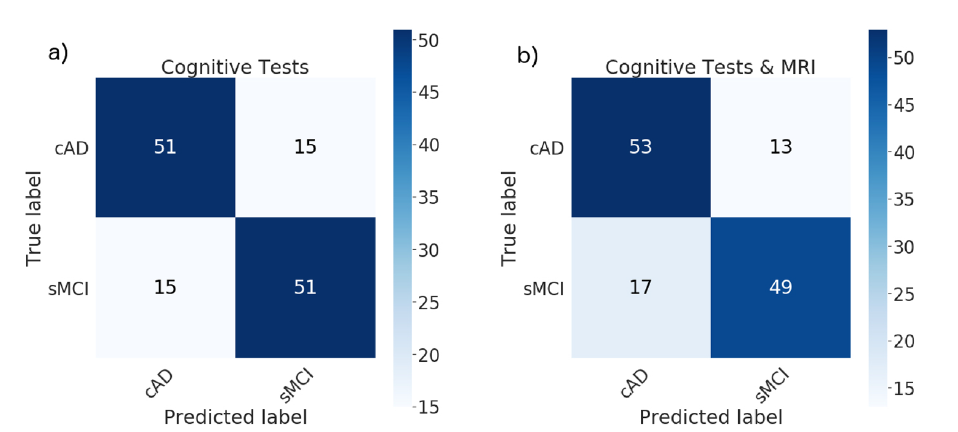
Figure 5. The trajectories for the normalized volumes of the hippocampus and the lateral ventricle in the left hemisphere with age at scan at the x-axis. The thick black curve is the cohort regression line, and the thin grey lines are random effects for each subject.